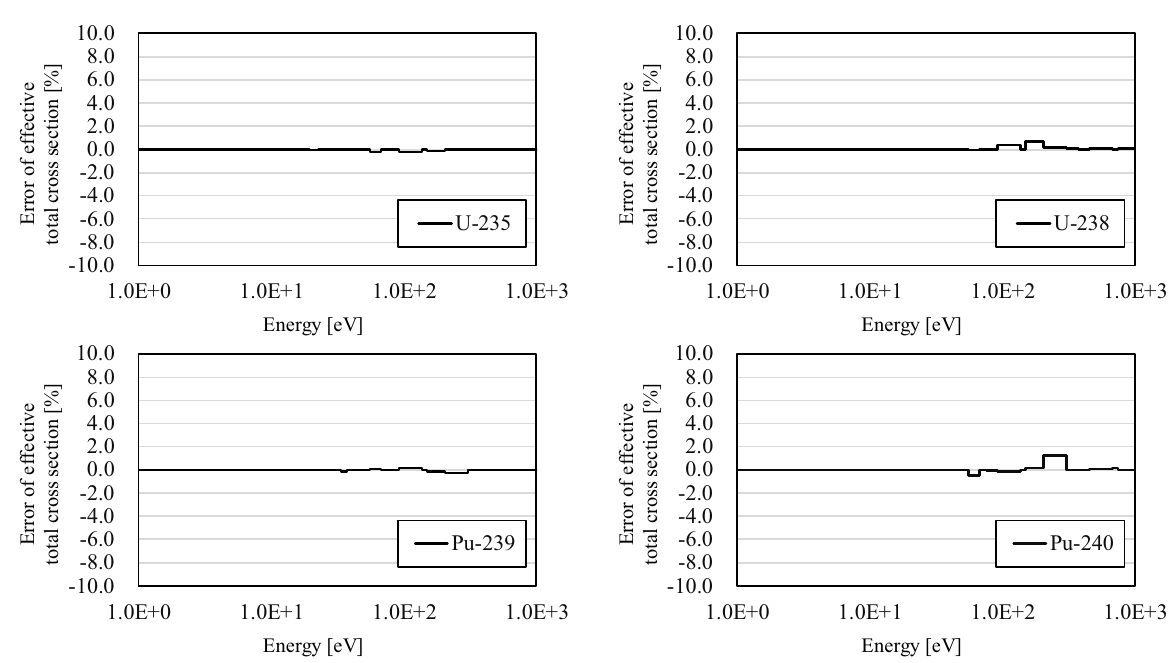
Figure 5. Error of effective total cross sections of U-235, U-238, Pu-239, and Pu-240 in MOX of Fig. 1-(b).